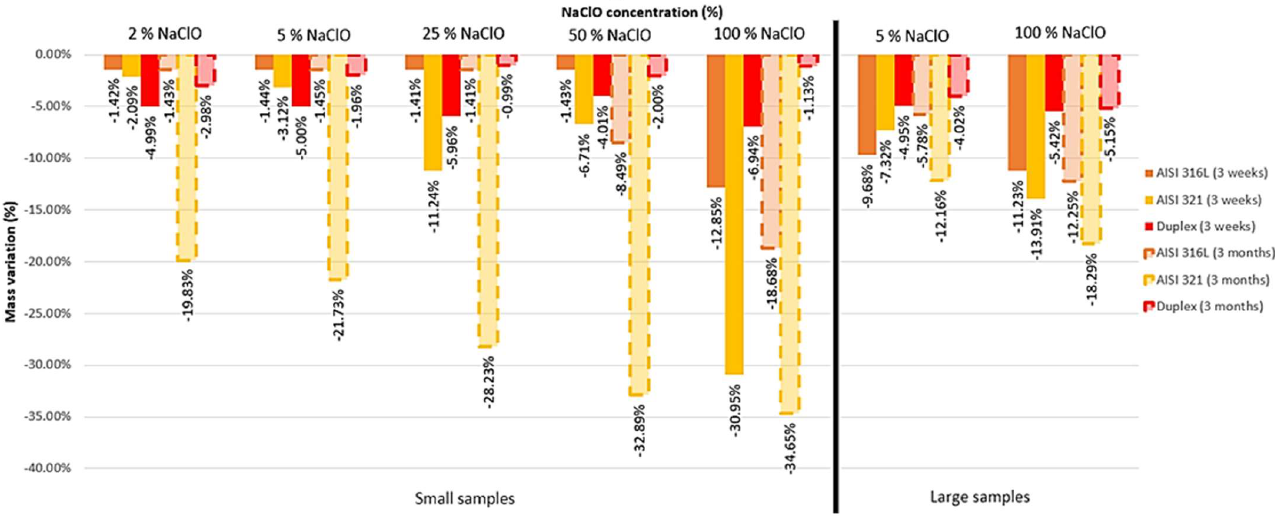
Figure 1. Dry samples of AISI 316L and AISI 321 after three weeks ( a , b ) and three months ( c , d ).